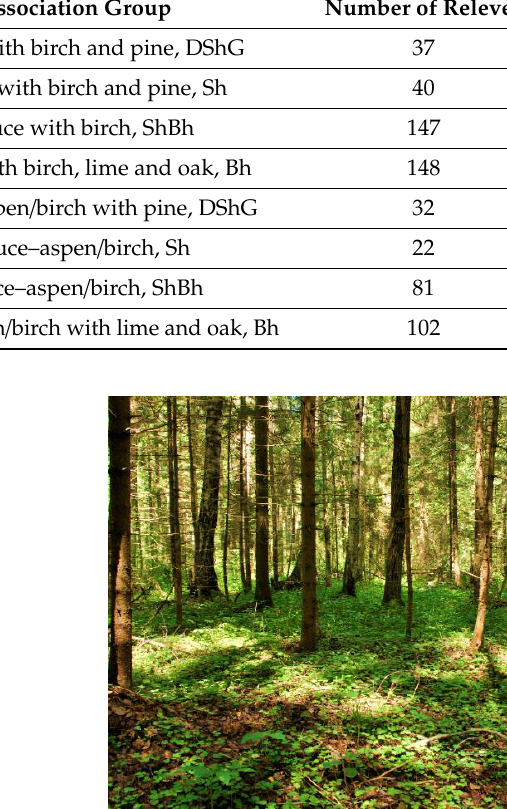
Table 2. Association groups of spruce and spruce–aspen / birch forests.